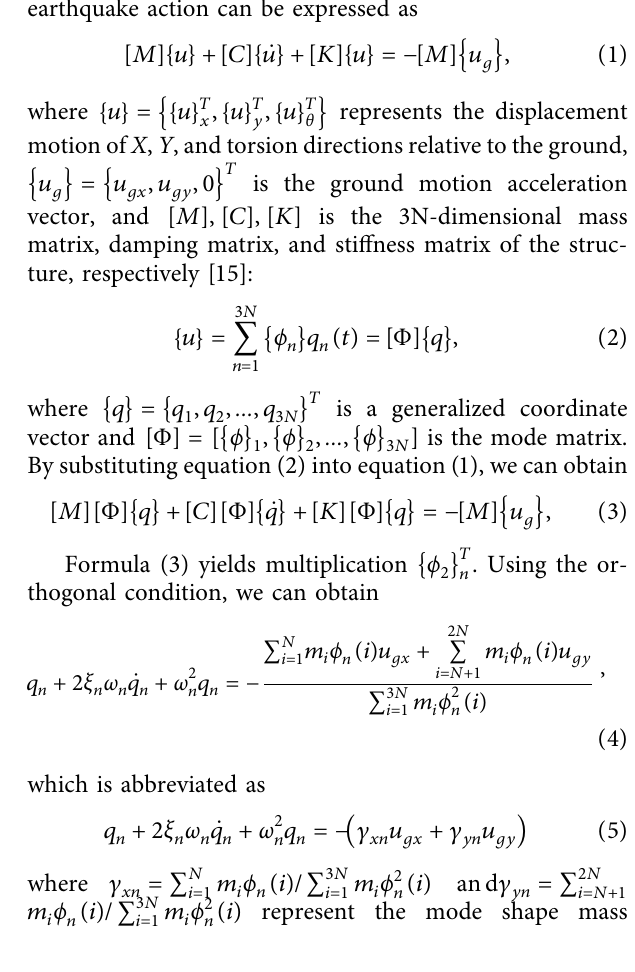
Figure 2: Full-bridge fnite element